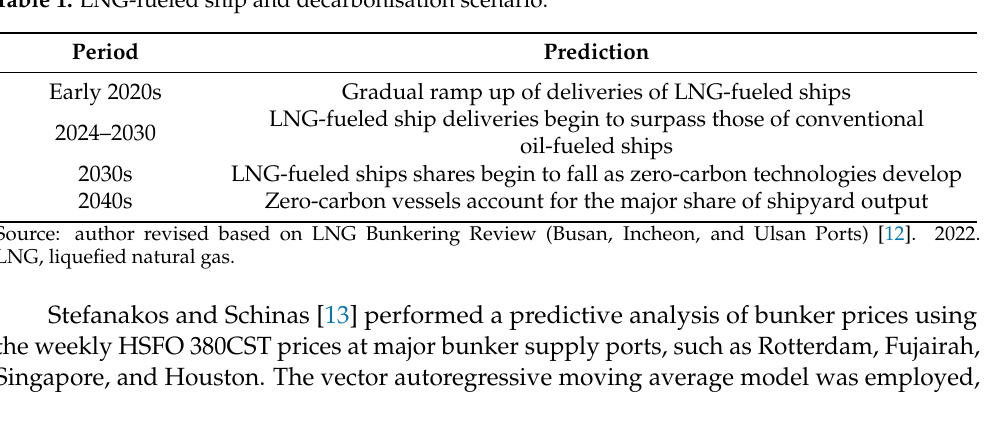
Table 1. LNG-fueled ship and decarbonisation